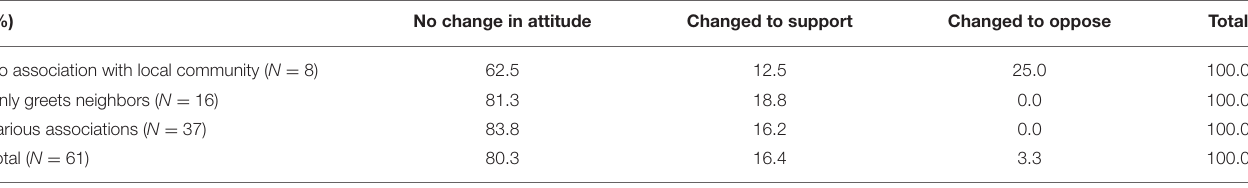
TABLE 7 | Changes before and after deliberations regarding the pros and cons of adaptation policies that local governments can implement by social capital (measures to provide facilities such as levees and dams, and to strengthen the development of monitoring environments). (%)